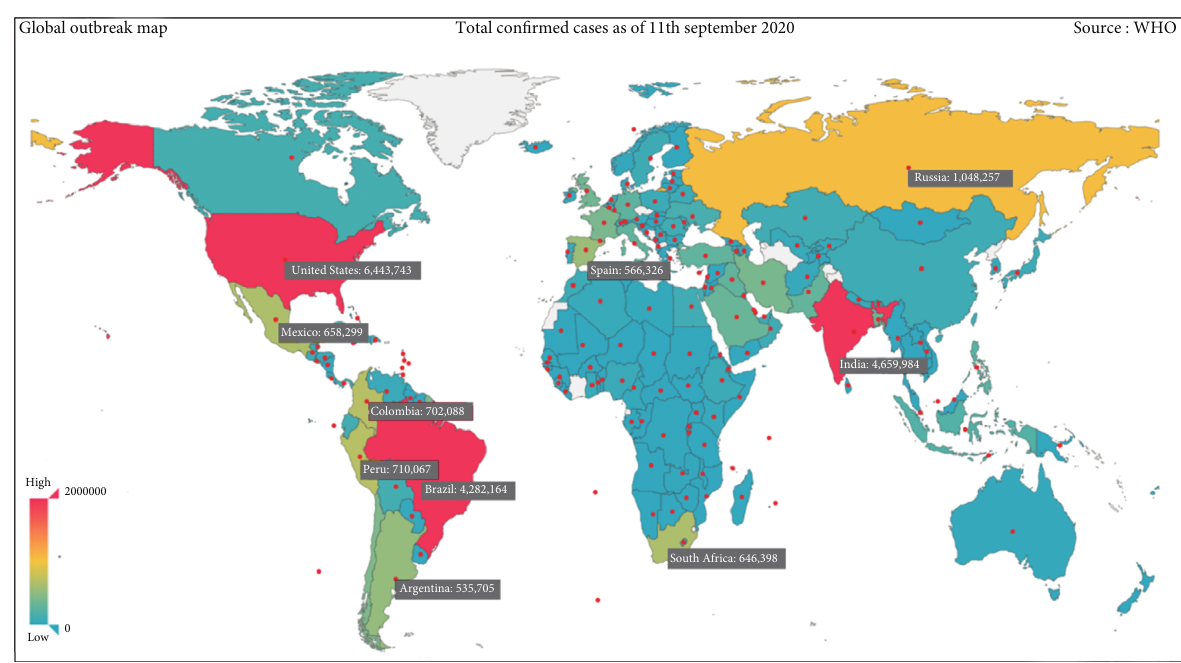
Figure 1: Distribution of global COVID-19 outbreak hotspots. As of 19:30, 12 th September 2020, the global confirmed cases were 28,692,299 and death cases 920,463. Over 1000 cases were confirmed in more than 15 countries, while 97570 cases were reported in India, 47855 cases in USA, and 43718 cases in Brazil (source: WHO